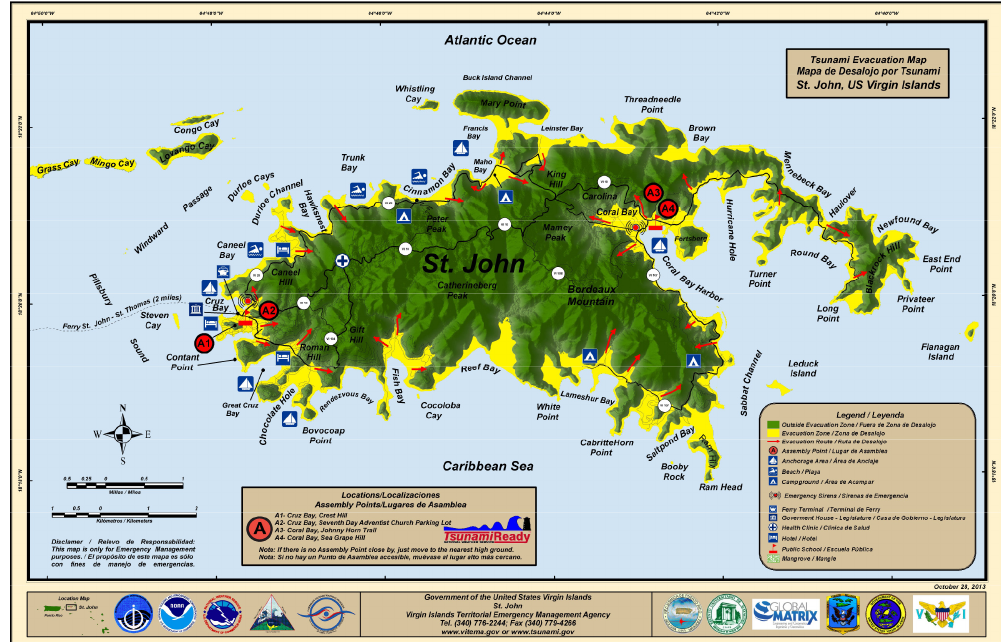
Fig. 5. Tsunami evacuation map for St. John, USVI. The yellow portions are land areas that are below 25m (82feet) elevation and are considered zones to be evacuated (VITEMA, 2013).